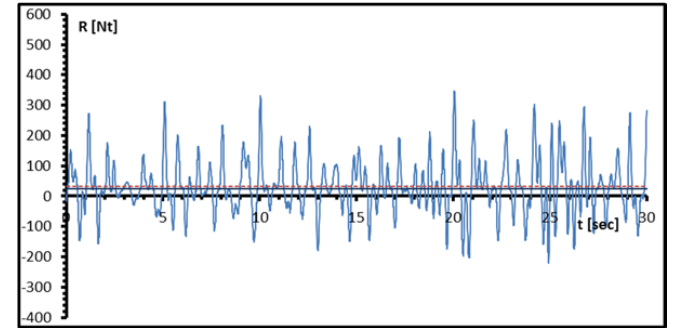
Figure 20. Resistance time series for Experiment #8.